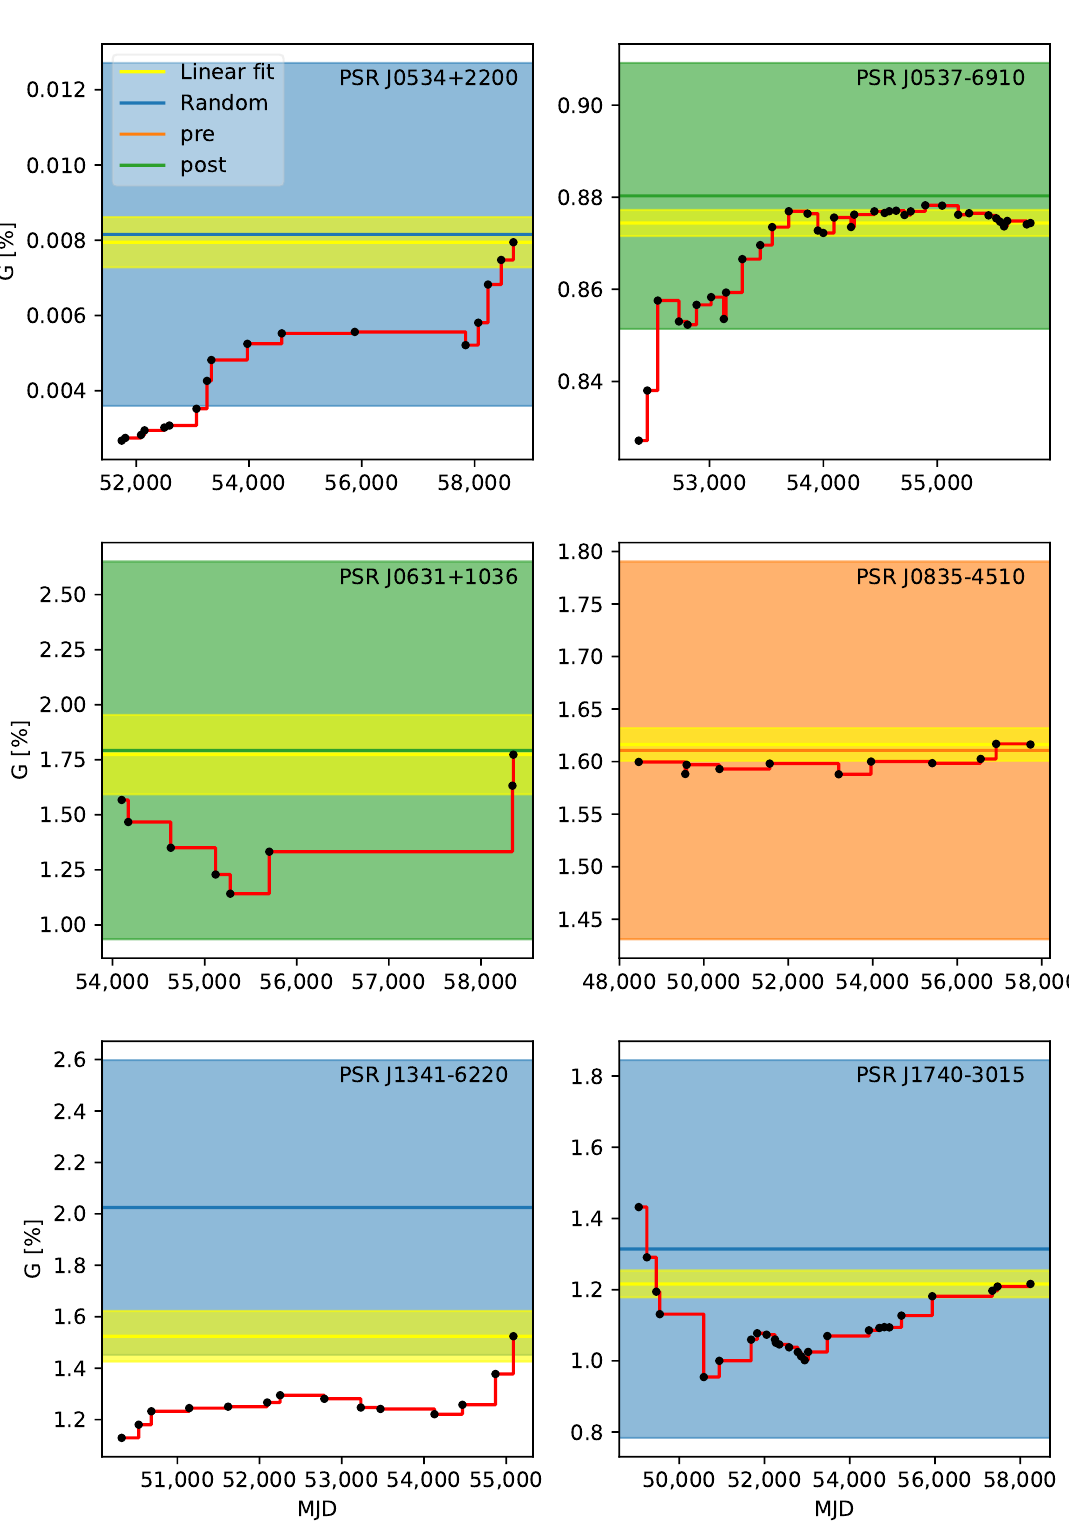
Figure 3. Evolution of the glitch activity over time. The first point of each curve is the activity calculated employing the linear fit on the cumulative midpoints of the first ten glitches, assuming homoscedasticity. The subsequent points are calculated by gradually adding all the glitches that pulsar displayed. For each pulsar, the estimate of the activity via ordinary linear regression with all glitches (in yellow) is shown, along with its uncertainty (shaded). We also present the bootstrap estimates and their uncertainties in the G post case for PSR J0537-6910 and PSR J0631+1036 (green), G pre for PSR J0835-4510 (Vela, orange) and G rand for all other stars